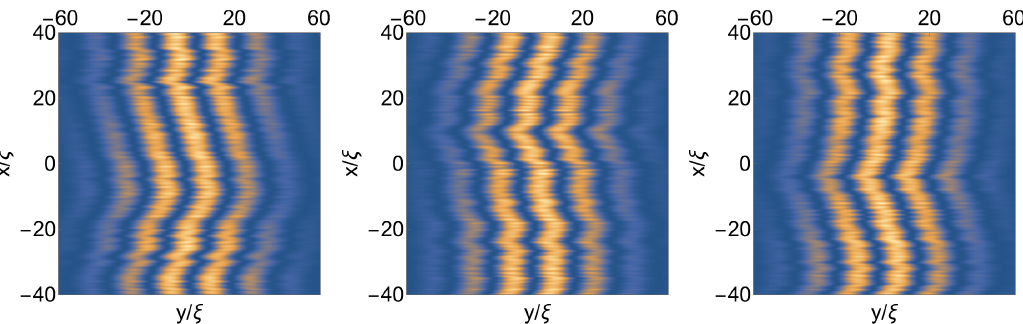
Figure 4: Samples of outcomes for individual (simultaneous) measurements of ( x , (cid:126) r , t + t ) at t = 14 ξ/ v and t = 16ms. The plots were produced using ˆ ρ tof 1 0 0 1 ˆ θ (22), including the term proportional to ∂ . The temperature in the symmetric sec- x s T = 0.5 ħ h ω ⊥ , using the parameters presented tor is 34nK, which corresponds to k B in Section 5.3.